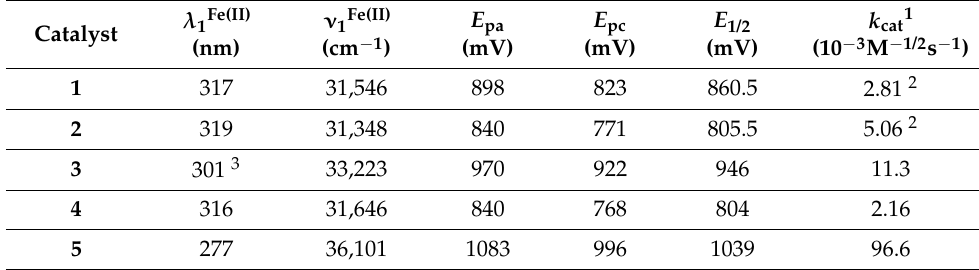
Table 1. Summary of spectroscopic and redox potential data of iron(II) precursor complexes compared with their catalase-like activity.